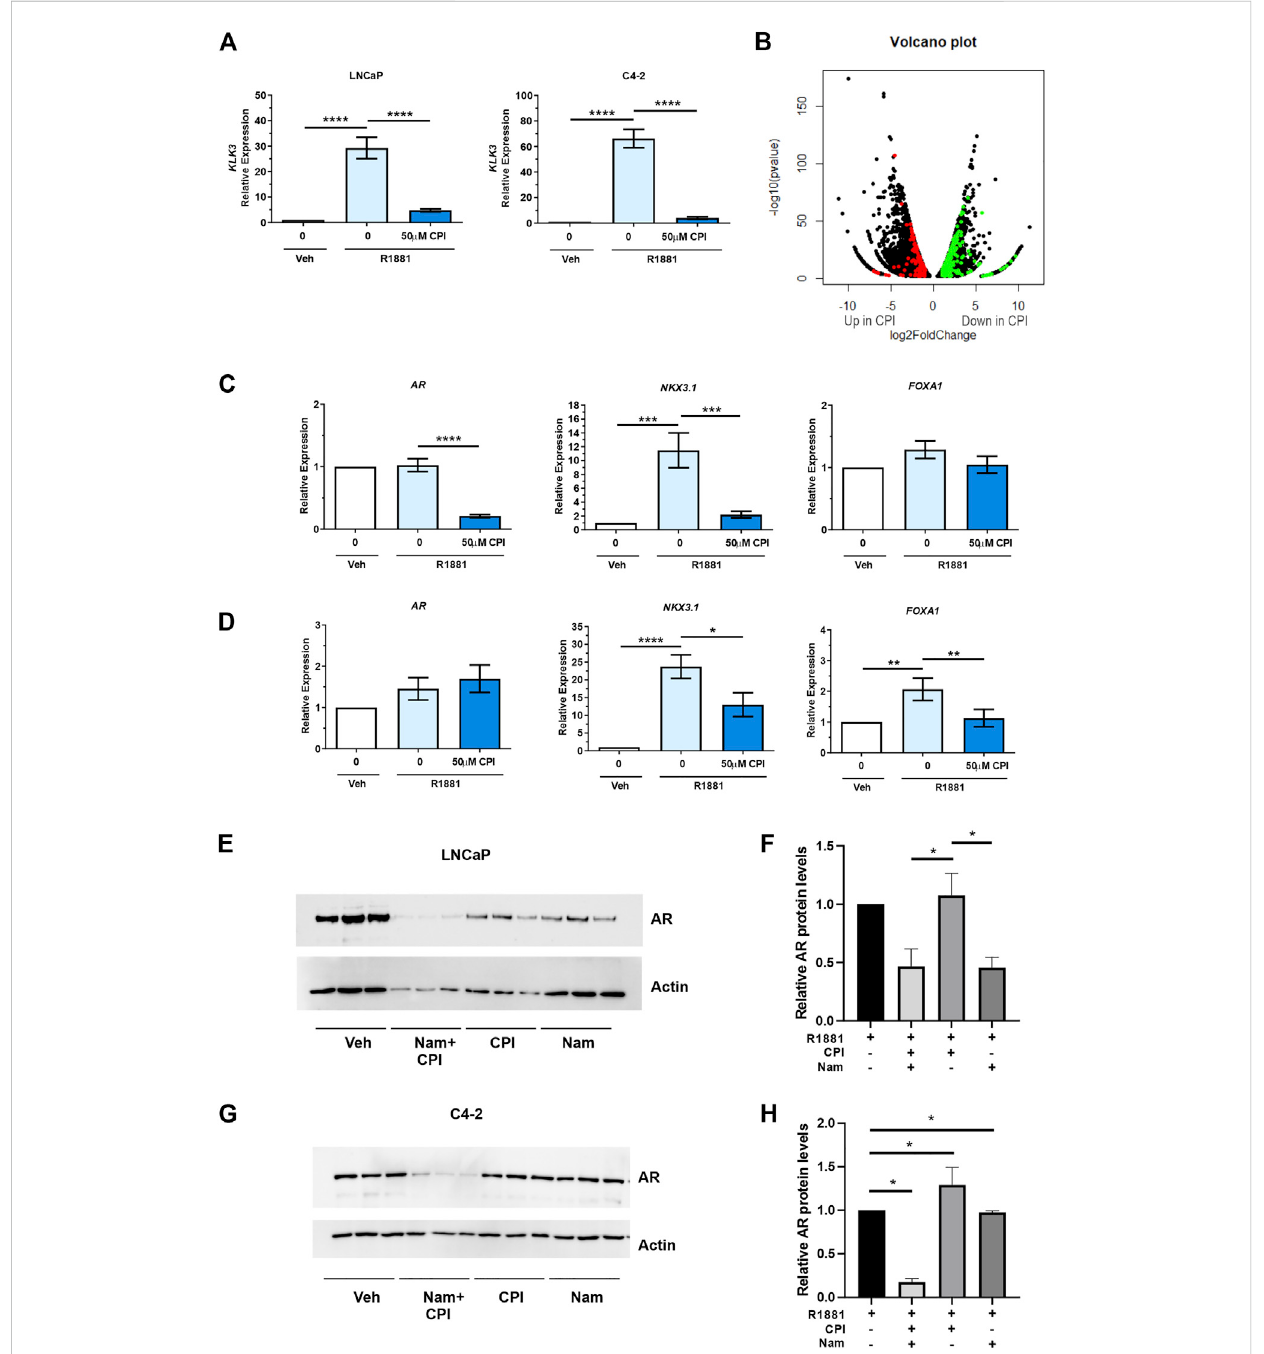
FIGURE 4 KDM5 inhibitor treatment effects on AR and the transcriptome in PCa cell lines LNCaP and C4-2. CPI-455 (CPI) treatment in the presence of synthetic androgen R1881 (1 nM) was performed for 72 h. (A) RT-qPCR of AR target gene KLK3 levels (normalised to GAPDH ). Androgen induction signi fi cantly attenuated with CPI-455 treatment. (B) Volcano plot of the differentially expressed genes between vehicle + R1881 and CPI-455 + R1881treated LNCaP cells. A negative log2 fold change (FC) shows genes upregulated with CPI-455 treatment and positive log2 FC value genes downregulatedwithCPI-455treatment.RedandgreenspotshighlightARtargetgenesthatareupordownregulatedbyCPItreatmentrespectively. (C,D) RT-qPCR validation of AR and AR target gene, NKX3.1 and pioneer factor FOXA1 in both LNCaP (C) and LNCaP: C4-2 (D) . (E,G) Immunoblot showing the AR levels after 72 h of KDM inhibitor treatments for LNCaP and LNCaP:C4-2 respectively. Relative AR protein levels for LNCaP (F) and LNCaP: C4-2 (H) were calculated by normalising to Actin signal and calibrating to vehicle ( n = 3, for each treatment). Veh – Vehicle control 0.1% DMSO, CPI – CPI- 455 (50 µM), Nam – Namoline (50 µM). Signi fi cance shown as p -values * p ≤ 0.05, ** p ≤ 0.005, *** p ≤ 0.001, * p ≤